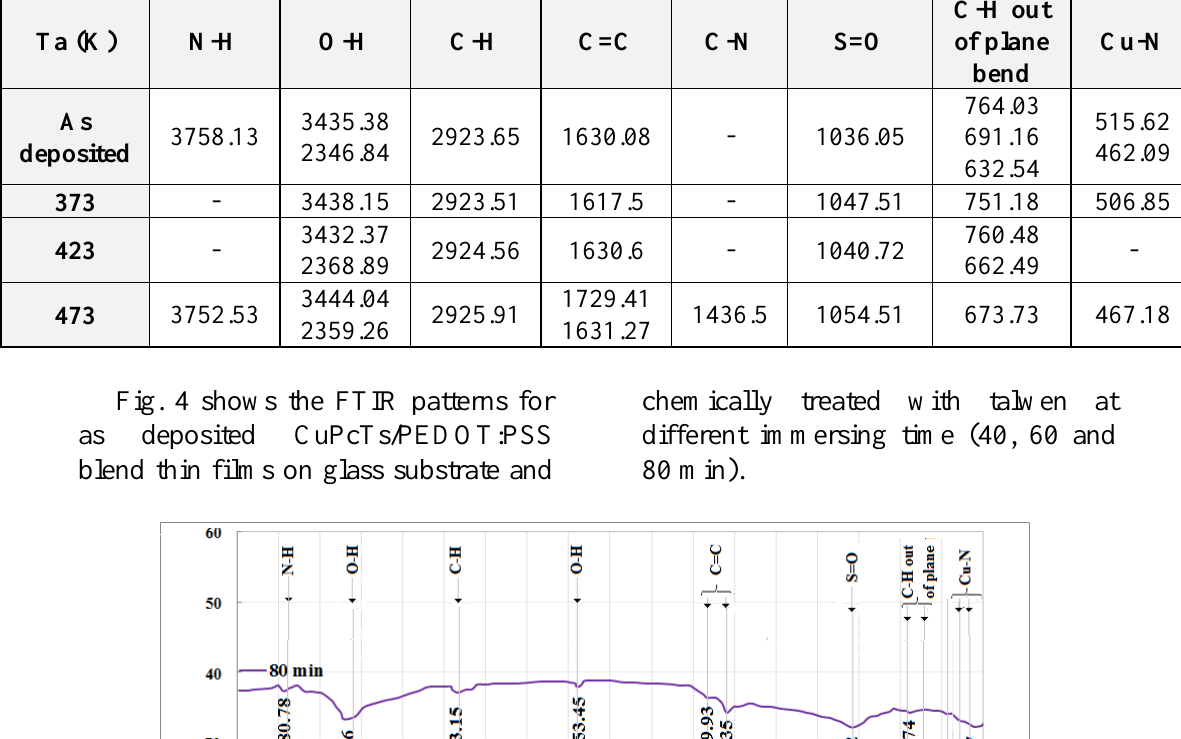
Table 3: FTIR bond for CuPcTs:BEDOT PSS thin films at different annealing temperatures Ta (K) As deposited